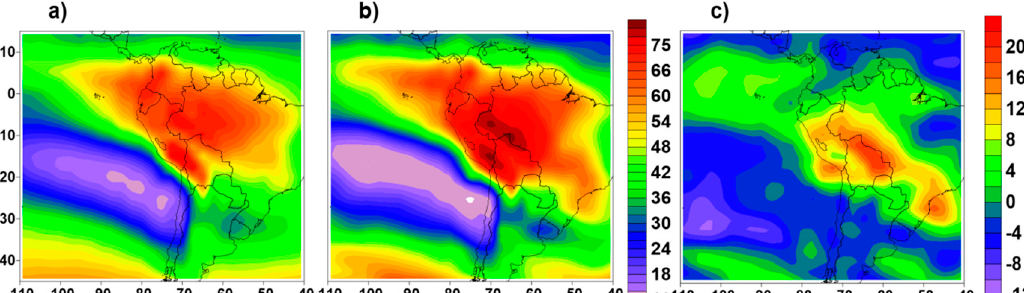
Figure 8. Composite wind fields averaged over the 40 extreme rainfall event cases for 700 hPa ( a ) and 500 hPa ( b ) in m s − 1 .